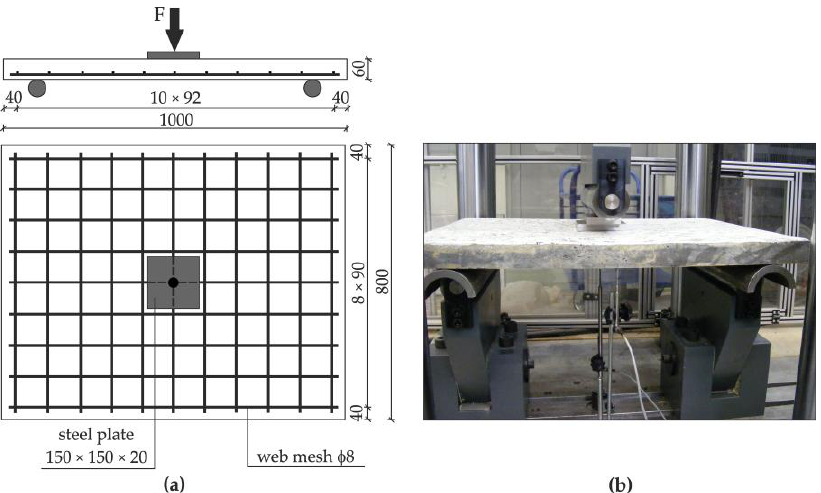
Figure 2. ( a ) Dimensions and reinforcement arrangement of test slabs (unit in mm); ( b ) Test set-up.